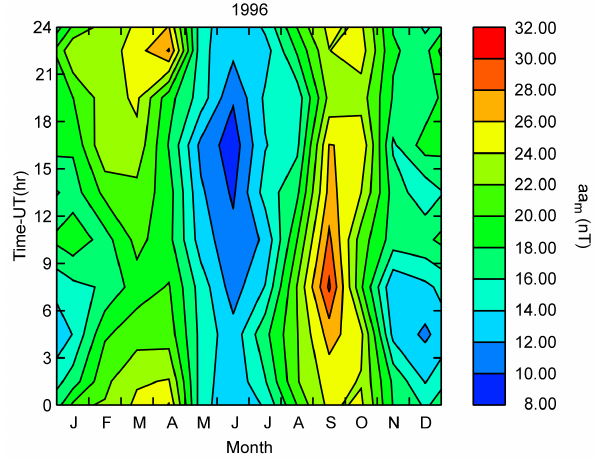
Fig. 2. Diurnal/seasonal variation of the aa m index during